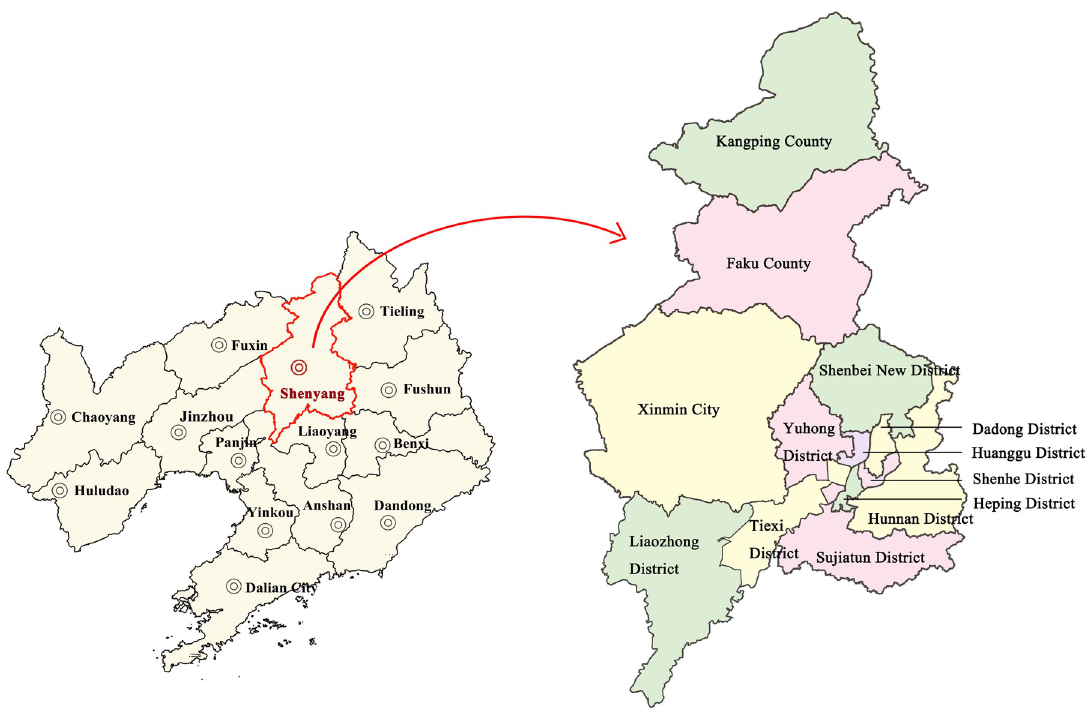
Fig 1. Study area (Image source: https://www.naturalearthdata.com/downloads/10m-cultural-vectors/).